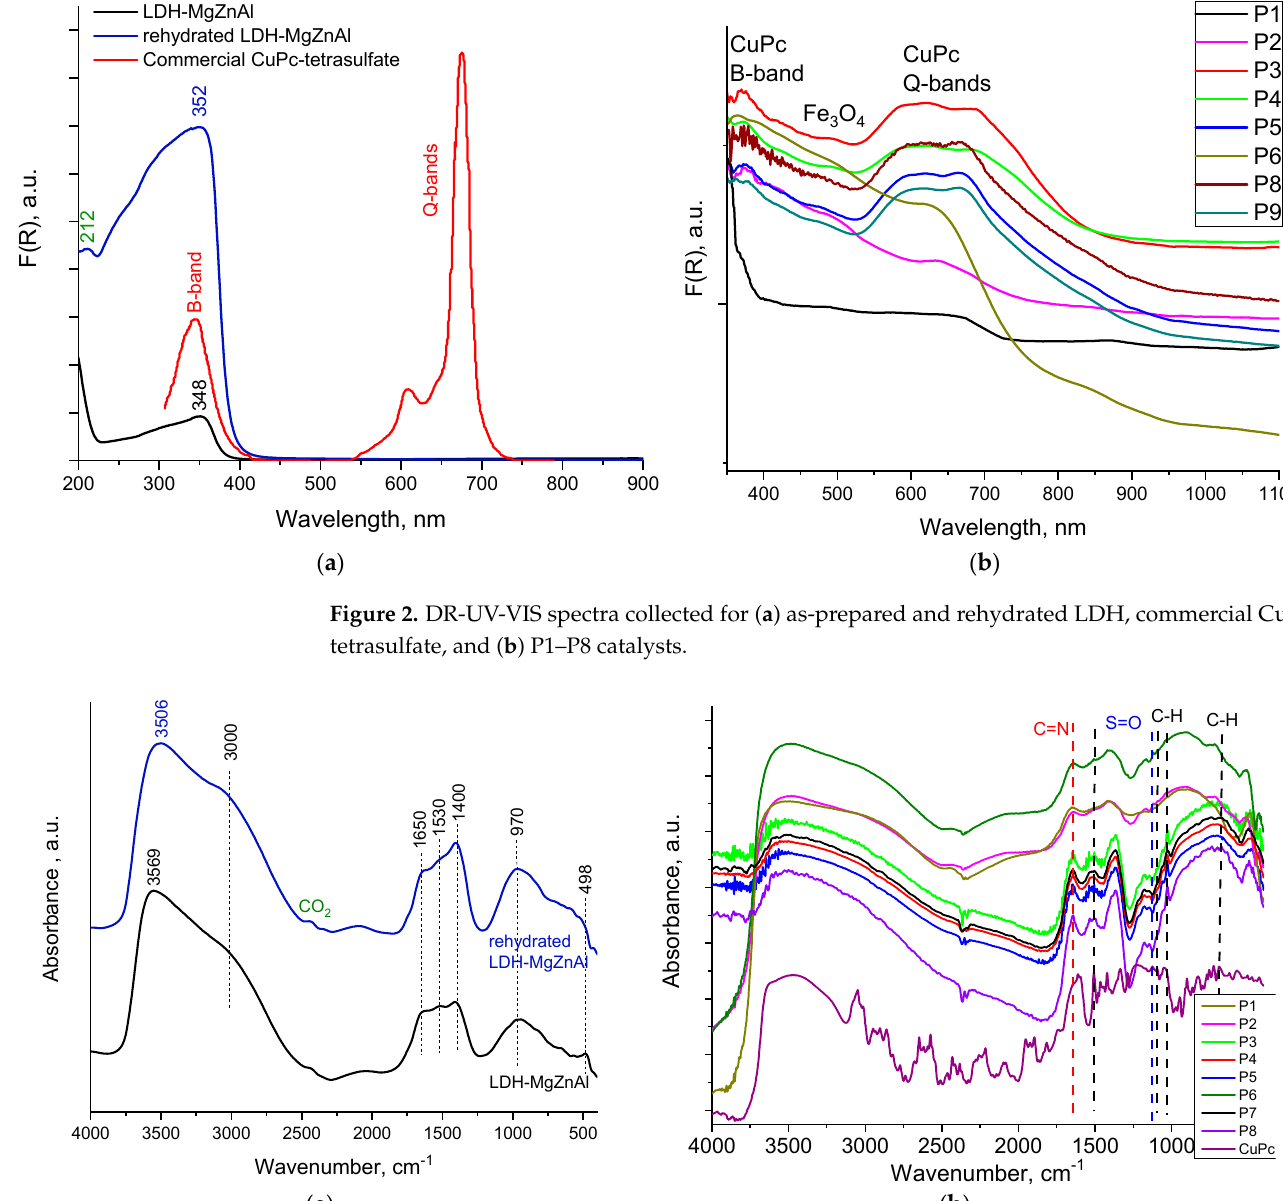
Figure 3. DRIFT spectra collected for ( a ) as-prepared and rehydrated LDH and ( b ) P1–P8 catalysts and commercial CuPc tetrasulfate.